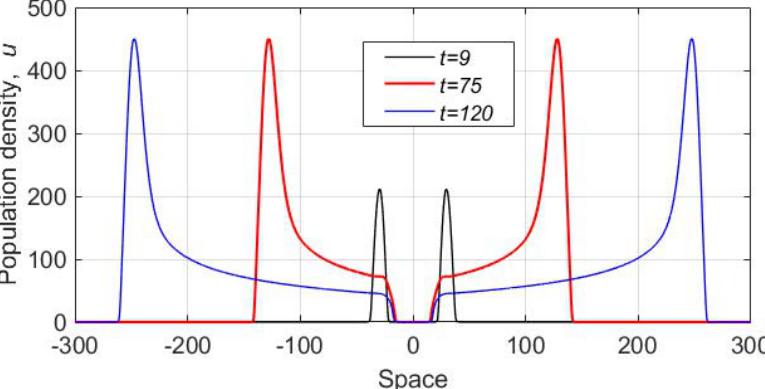
Figure 10. Population density vs. space obtained as a solution of Model (12) for (cid:101) = 0.1 shown at different moments of time. Other parameters the same as in Figure 8.